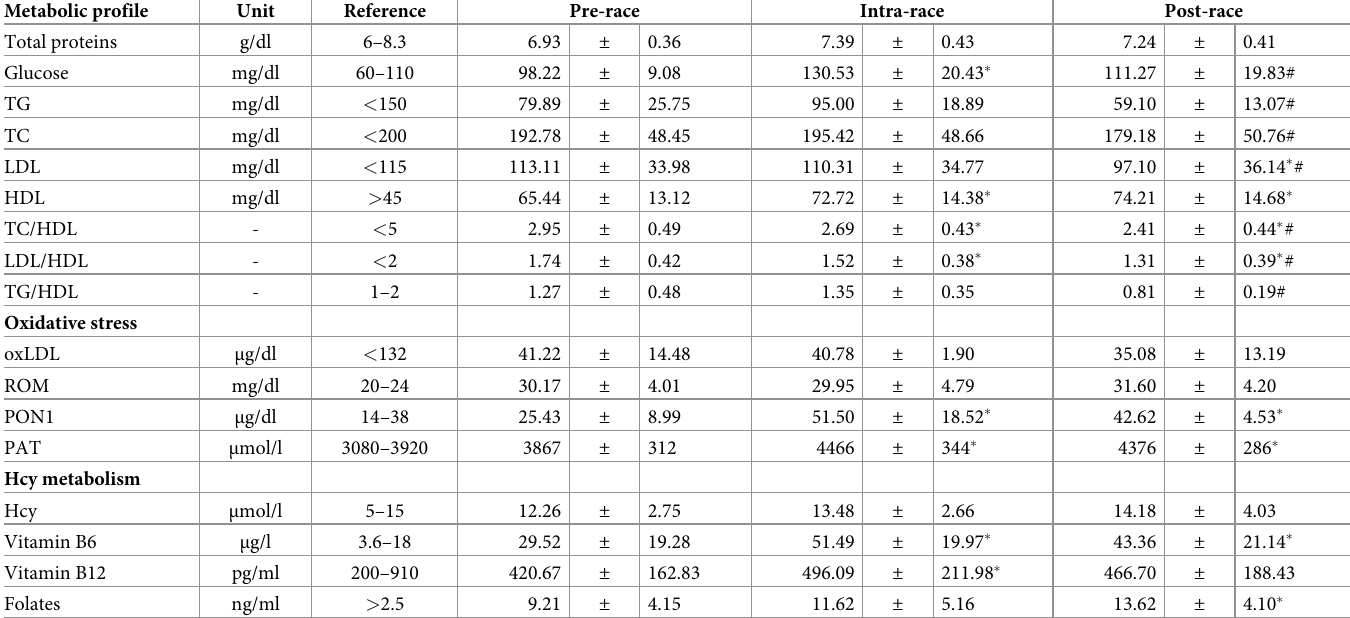
Table 3. Ultramarathon-induced changes in blood parameters related to metabolic profile, oxidative stress, and Hcy metabolism. Data, obtained from athletes which completed the race (n = 9), are corrected for Ht § and expressed as mean±SD. Metabolic profile Unit Reference